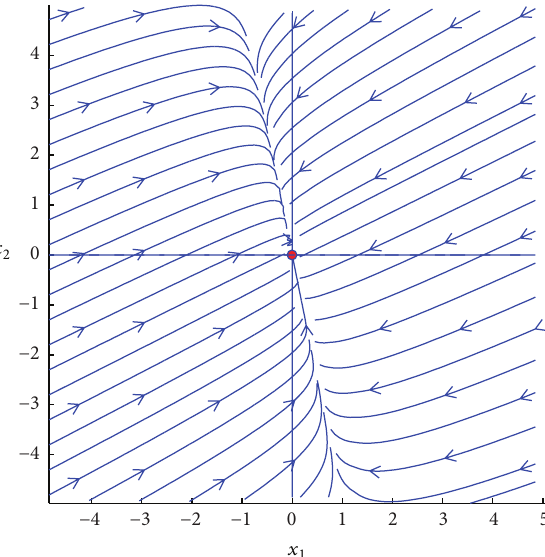
Figure 1: Phase portrait of switching linear system with two